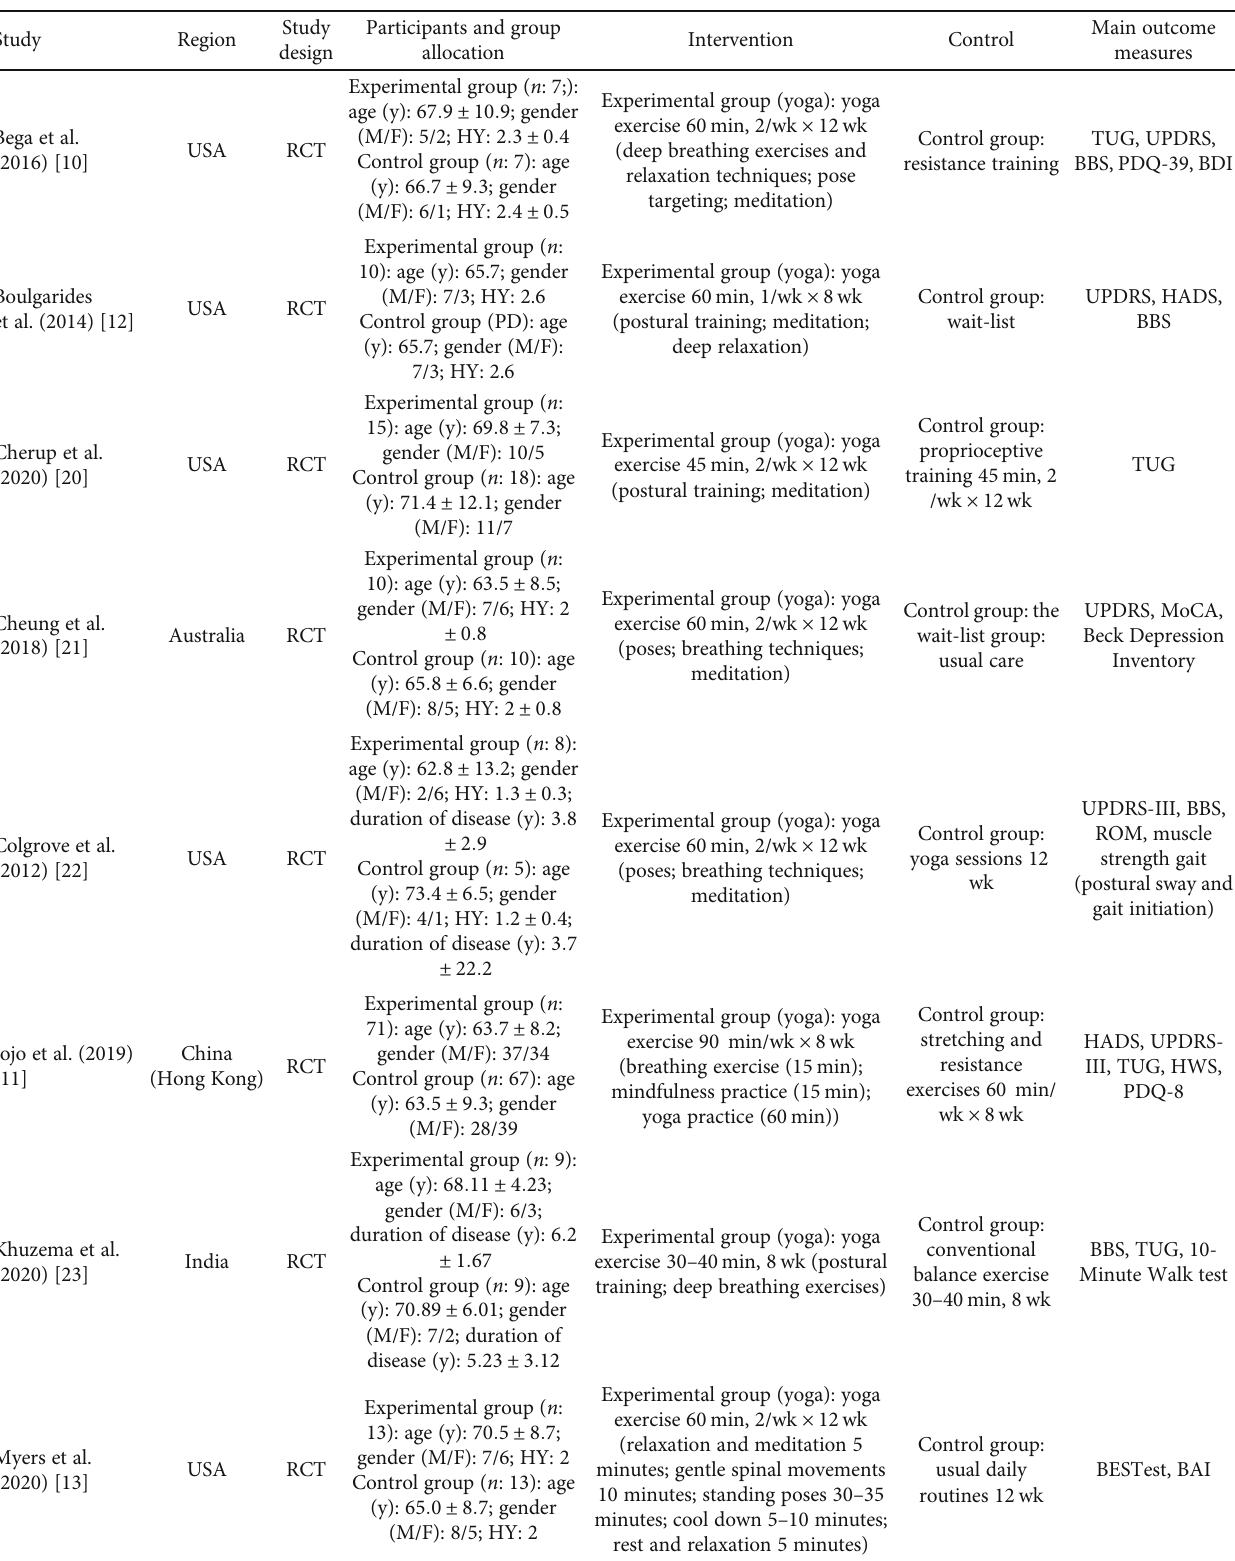
Table 1: Characteristics of included